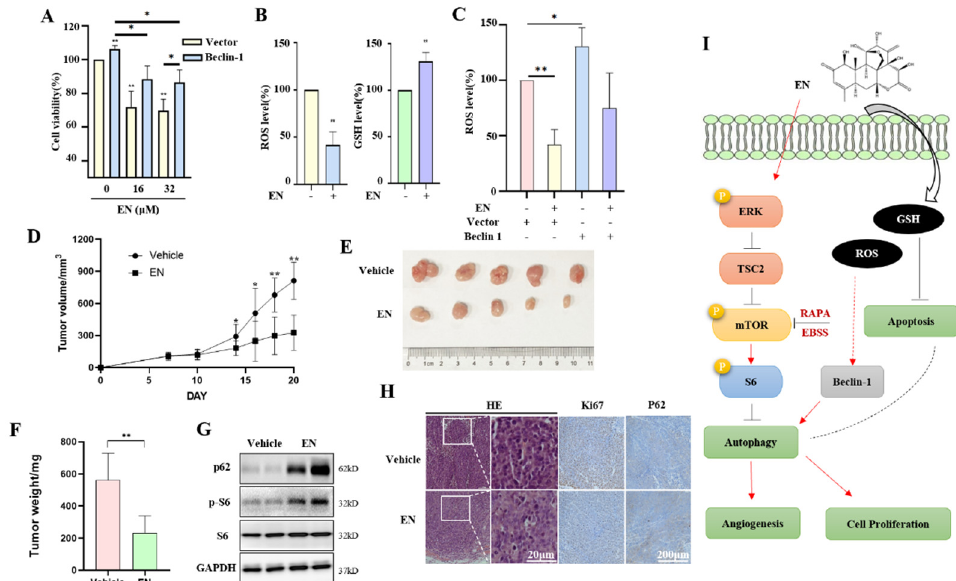
Figure 5. Autophagy protects against EN-induced cell death. ( A ) HCT116 cells were first transfected with Flag-Beclin-1 and then treated with EN (16 or 32 µ M) for 24 h. Cell activity was measured by MTT assay. * p < 0.05, ** p < 0.01. ( B ) HCT116 cells were treated with EN (16 μ M) for 24 h, and then DCFH-DA (2 μ M) or GSH (10 nM) were used for cell staining. Flow cytometry was used to measure cell fluorescence. ** p < 0.01. ( C ) As in ( A ), EN-treated cells were stained with DCFH-DA (2 μ M), and flow cytometry was used to detect cell fluorescence intensity. * p < 0.05, ** p < 0.01. ( D ) Female Balb/c nude mice were subcutaneously injected with SW620 cells to establish a xenograft tumor model, and then tumor-bearing mice were treated with EN (10 mg/kg) every two days. Tumor diameter was recorded, and tumor growth curves were plotted. * p < 0.05, ** p < 0.01. ( E ) At the end of the experiment, the mice were sacrificed, and the xenograft tumors were removed and photographed. ( F ) The excised tumors were weighted and statistically analyzed. ** p < 0.01. ( G ) Part of the tumor tissue was crushed and lysed for Western blotting. The expressions of p62, phospho- S6, and S6 were detected. ( H ) H&E staining and immunohistochemical staining of Ki-67 and p62proteins in the paraffin-embedded tissues were performed. Scale bar: 200 μ m. ( I ) An illustrative model of autophagy inhibition in EN against colon cancer. 3.6. EN Inhibits the Tumorigenesis of Colon Cancer and Autophagy In Vivo To confirm the in vitro study results, we used a xenograft model to determine the tumor suppression activity of EN. No mice died during the experiment, and no significant difference in body weight between the vehicle and EN treatment groups was observed. The tumor-bearing mice were sacrificed 24 h after the last administration of EN, and the tumor mass was removed. As shown in Figure 5D, treatment with 10 mg/kg EN inhibited tumor xenograft growth. The tumor weight decreased by 58.8% in the EN treatment group when compared with the vehicle (Figure 5E,F). These results demonstrate that EN exerts a tumor-suppressive effect in vivo. In addition, we also examined the autophagy level of the tumor tissue. The Western blotting results showed that the levels of autophagy substrates p62 and phosphorylated S6 were upregulated after the EN treatment (Figure 5G), indicating the activation of mTOR signaling and a decrease in the autophagy level. Meanwhile, H&E staining was performed to detect the nuclear condensation of tumor tissues, and immunohistochemical staining was also performed to detect the Ki-67 and p62 protein levels. Ki-67 is present during the active phases of the cell cycle (G1, S, and G2 phase) but is absent in resting cells (G0) [33]. Thus, the high expression of Ki-67 represents the high proliferation rate of tumor cells. Our results show that the level of Ki-67-positive cells (brown) was lower in the EN treatment group than in the vehicle group (Figure 5H). On the contrary, the p62 level increased with EN treatment and was consistent with the in vitro study results. The above